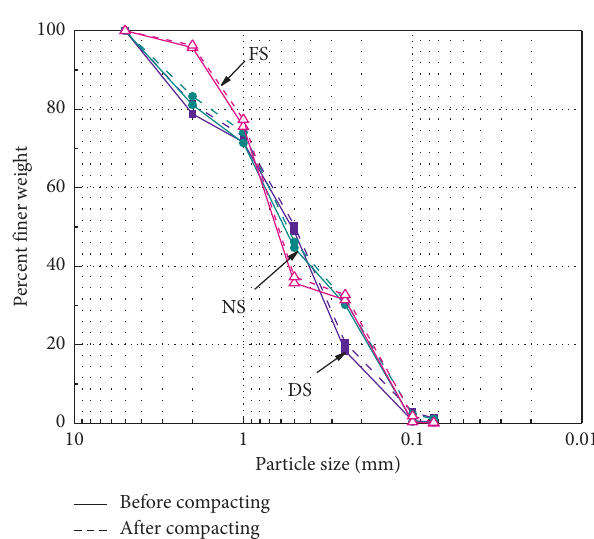
Figure 3: Particle size distribution curves of three types of natural sand.